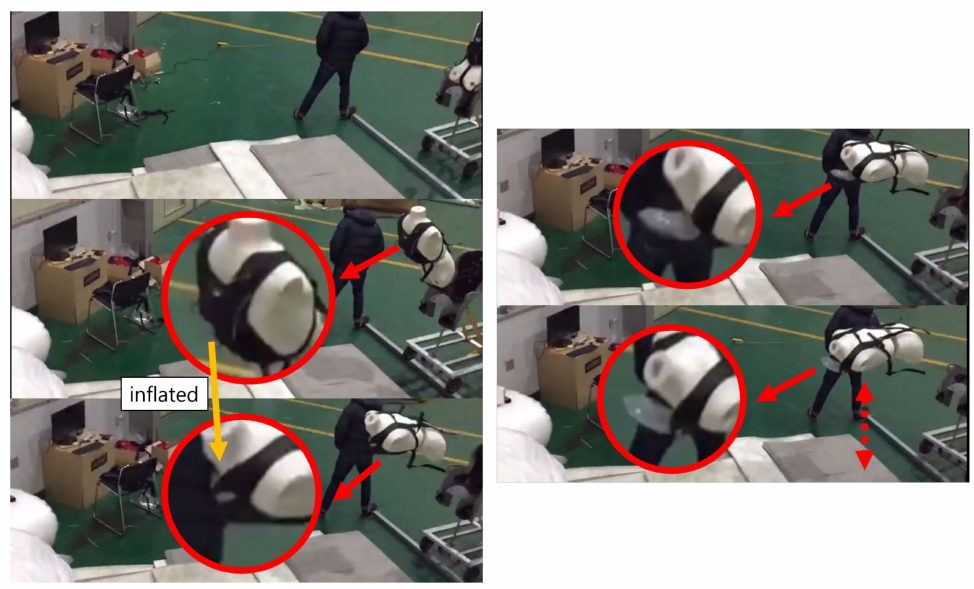
Figure 14. Airbag operation confirmation before the